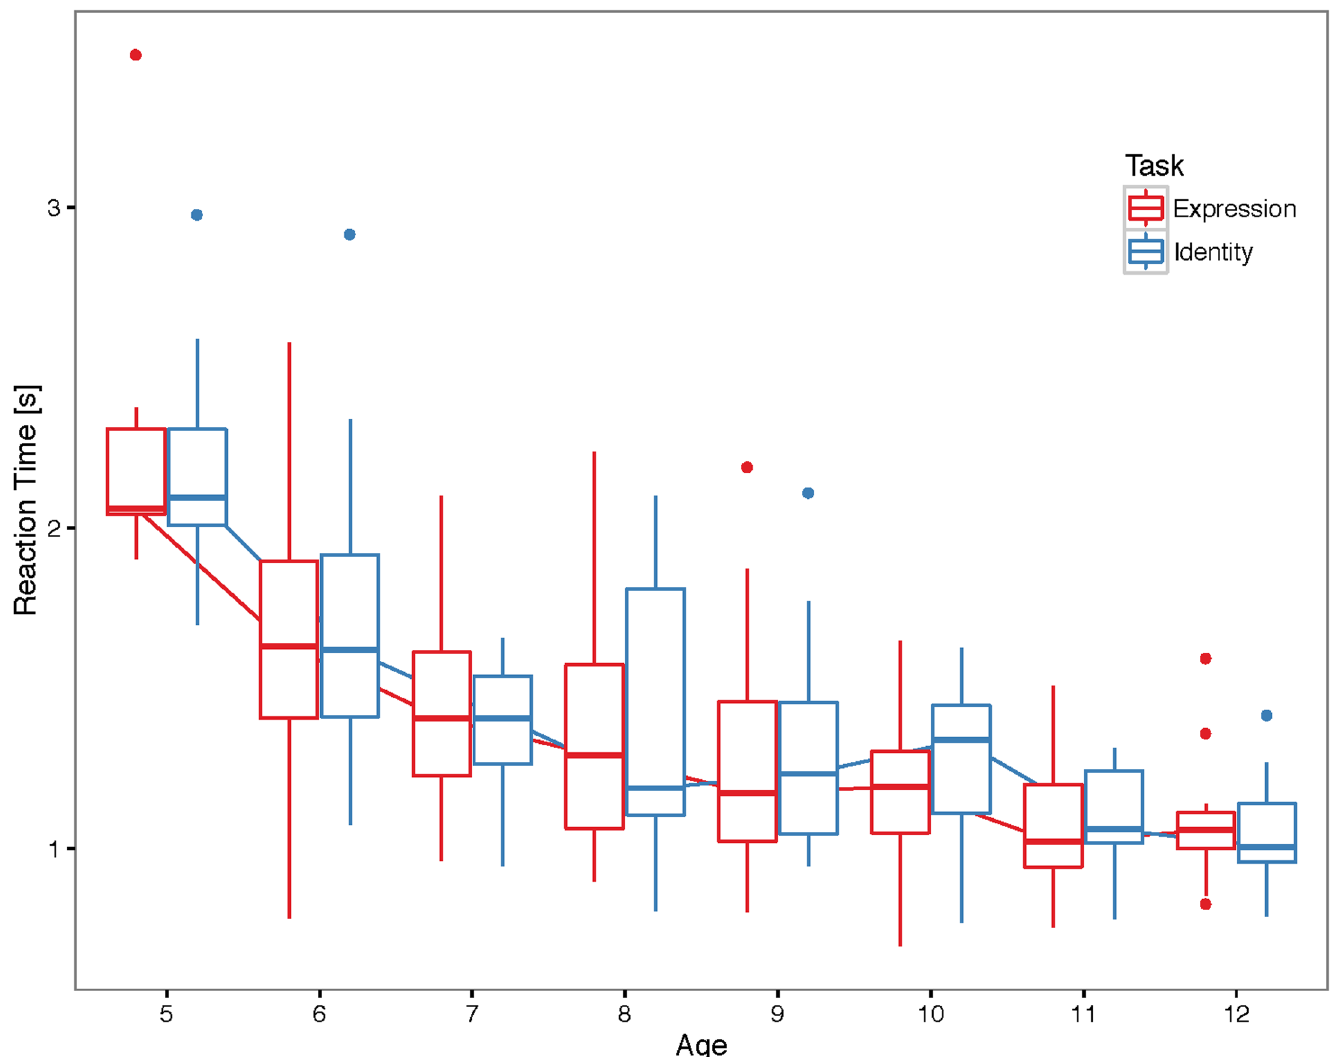
Fig 4. Participant reaction time. Boxplots showingaveragereactiontime for subjectsin each age group and task. Individual points represent outlier subjects (definedas those points exceeding1.5 times the inter-quartile range).